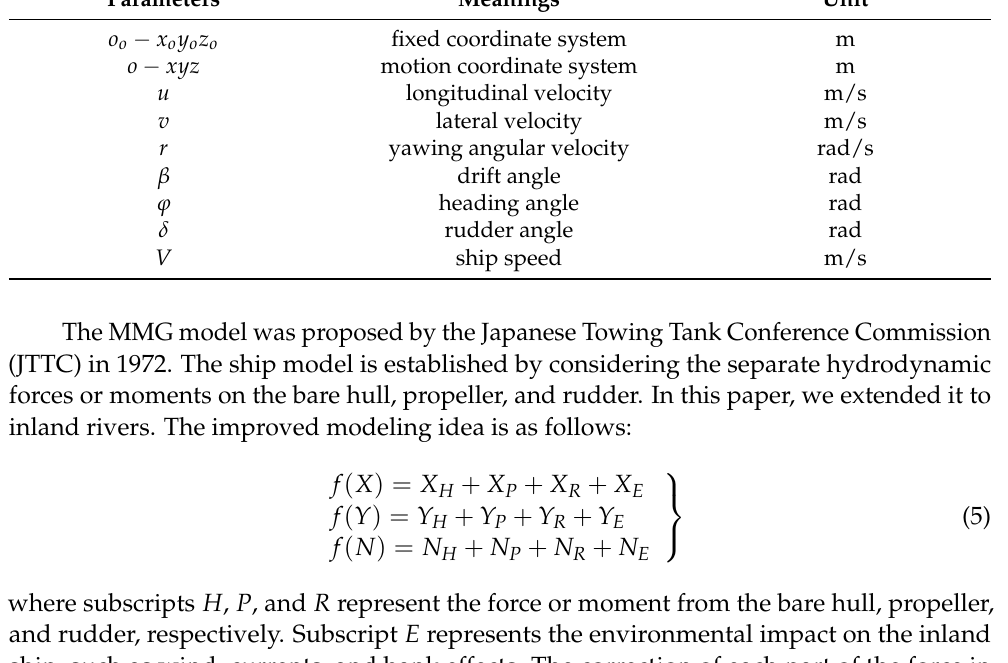
Figure 5. The horizontal view of the ship’s maneuverability motion coordinate system. Table 1. Coordinate system parameters.